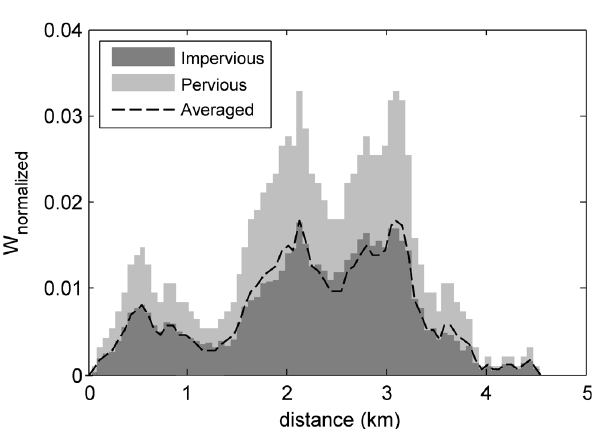
Fig. 4. Two width functions for pervious and impervious areas ob- tained from the imperviousness map in CDS-51 normalized by the total catchment area.